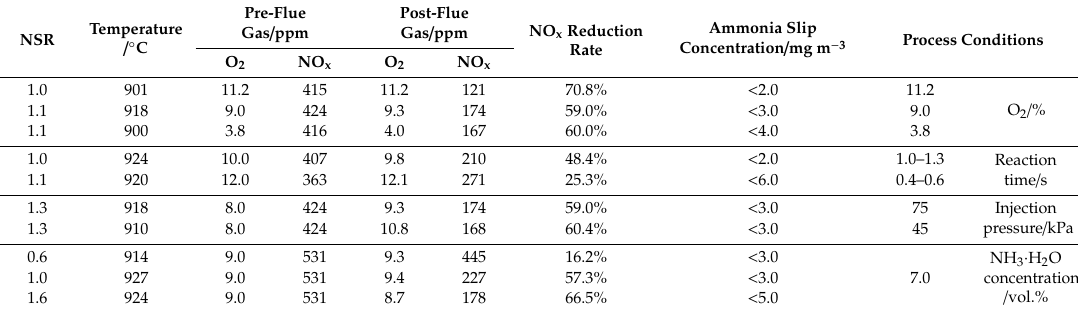
Table 3. E ff ects of process conditions on the NO x